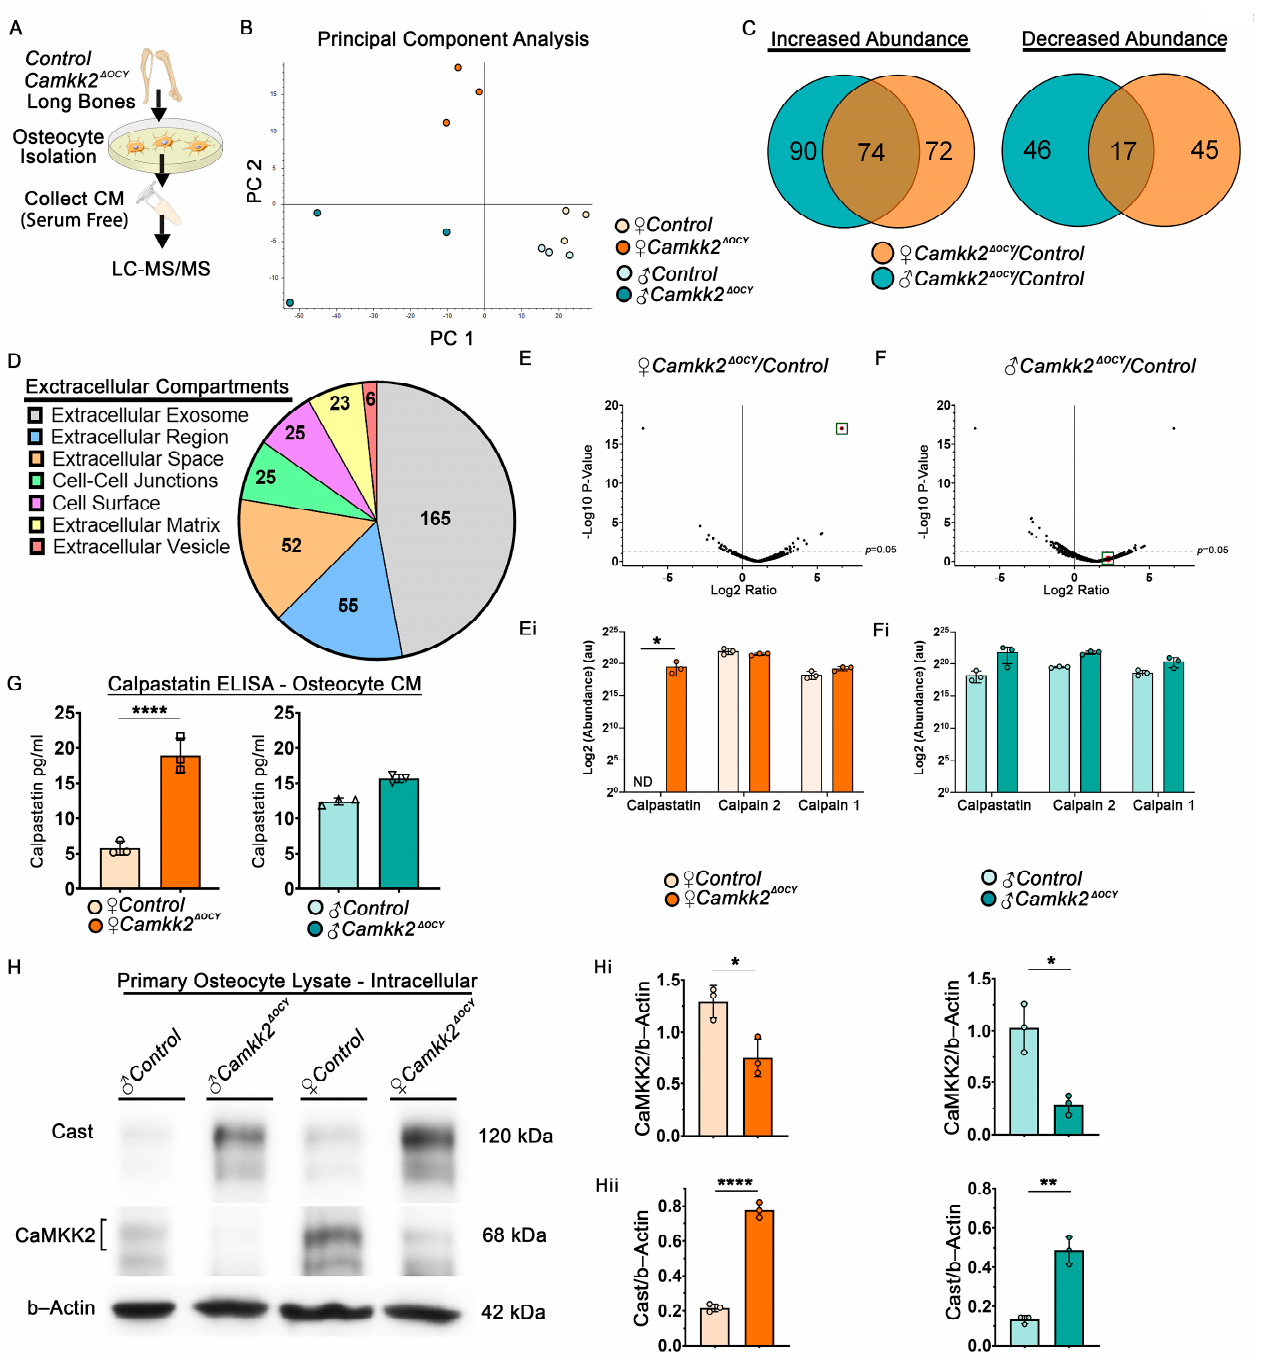
Figure 4. Calpastatin is enhanced in CaMKK2 deficient osteocyte conditioned media from female mice . ( A ) Scheme for primary osteocyte isolation from the long bones of individual female and male control and Camkk2 Δ OCY mice and collection of serum-free conditioned media for LC-MS/MS analysis. ( B ) Principal component analysis (PCA) plot of proteomic signatures of osteocyte CM ( n = 3/group). ( C ) Venn diagram of proteins with increased or decreased abundance in female and male Camkk2 Δ OCY osteocyte CM relative to sex-matched controls. ( D ) Pie chart showing functional anno- tation of osteocyte CM proteins. All GO-Terms with a minimum False Discovery Rate (FDR) cor- rected p -value < 0.05 were included. ( E , F ) Volcano plots of enriched proteins in female and male Camkk2 Δ OCY osteocyte CM relative to sex-matched controls . Calpastatin (Cast) is represented within the cluster colored as red (box). ( Ei , Fi ) Plots of Log2 (abundance) values for Cast, calpain (Capn)2 and Capn1 in female and male osteocyte CM. ( G ) Amount of calpastatin (pg/mL) in osteocyte CM